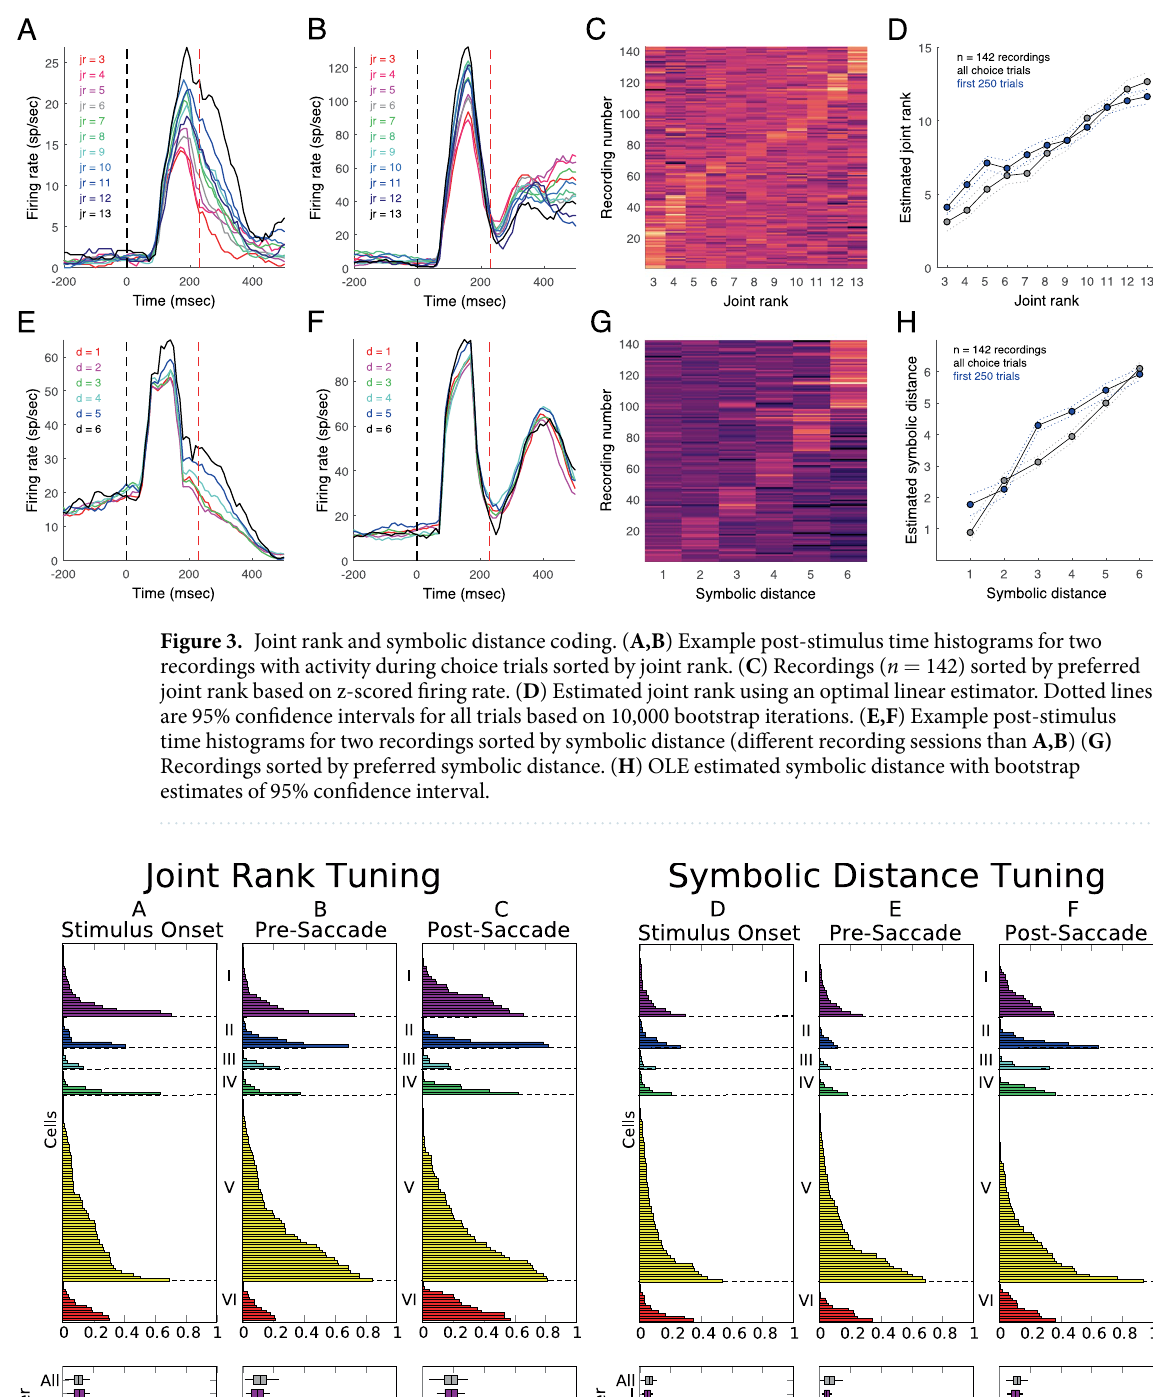
Figure 4. Variance accounted for by joint rank and symbolic distance, sorted by neuron class and by trial epoch. Box-and-whisker diagrams depict mean VAC for each cluster, with boxes corresponding to 80% credible intervals and whiskers corresponding to 95% credible intervals. Clusters are defined in Methods and Fig.